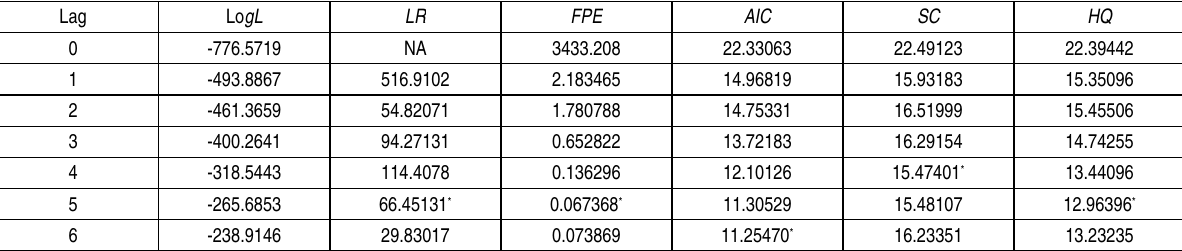
Table 2. Lag selection criterion